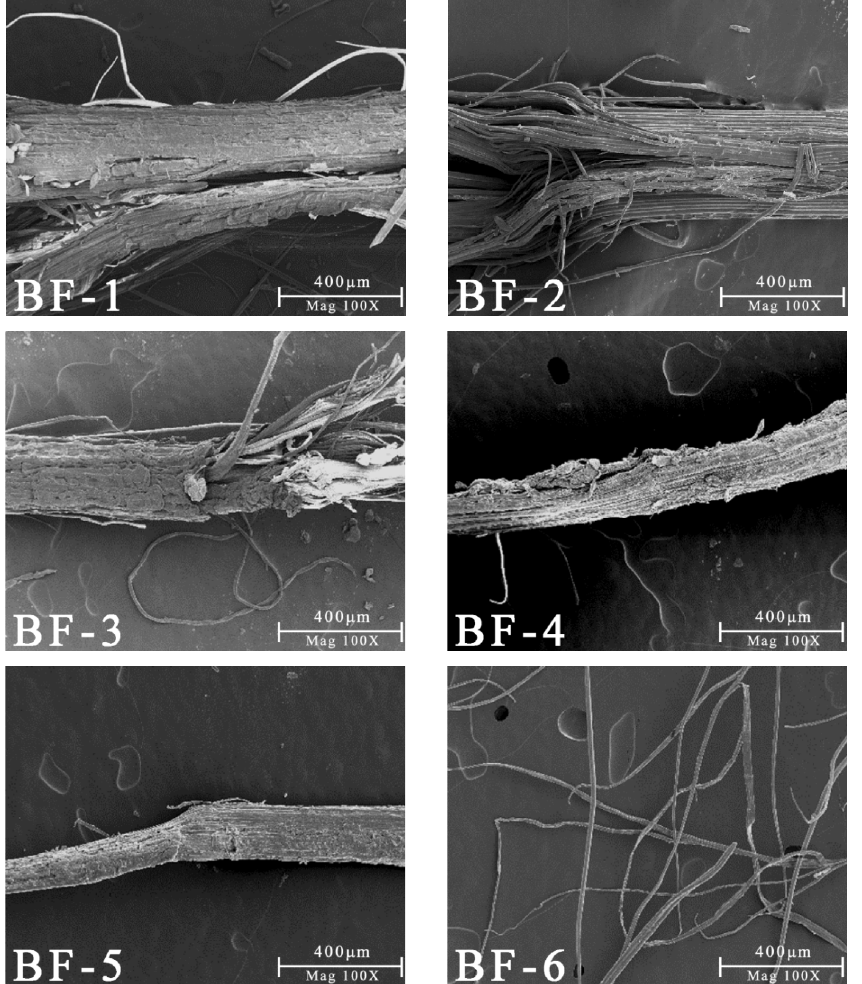
Figure 4. Microscopic morphology of bamboo fibers with different opening times.